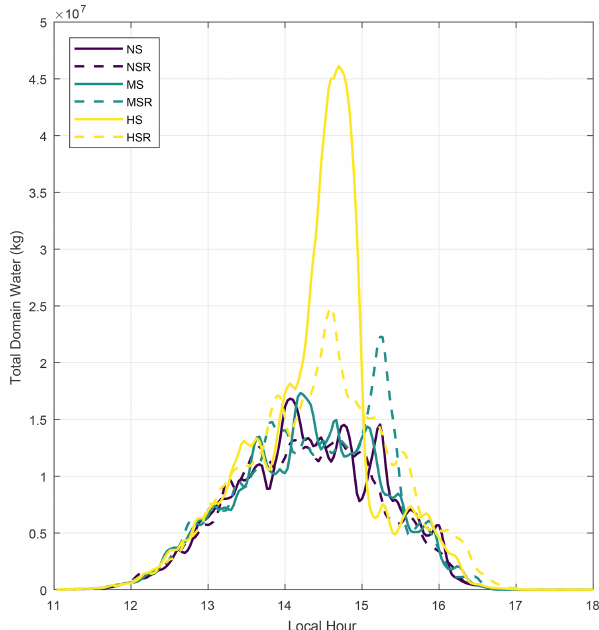
Figure 7. Time series of the total domain water (kg), calculated as the 3D integration of the cloud and rain liquid water contents over the entire simulation